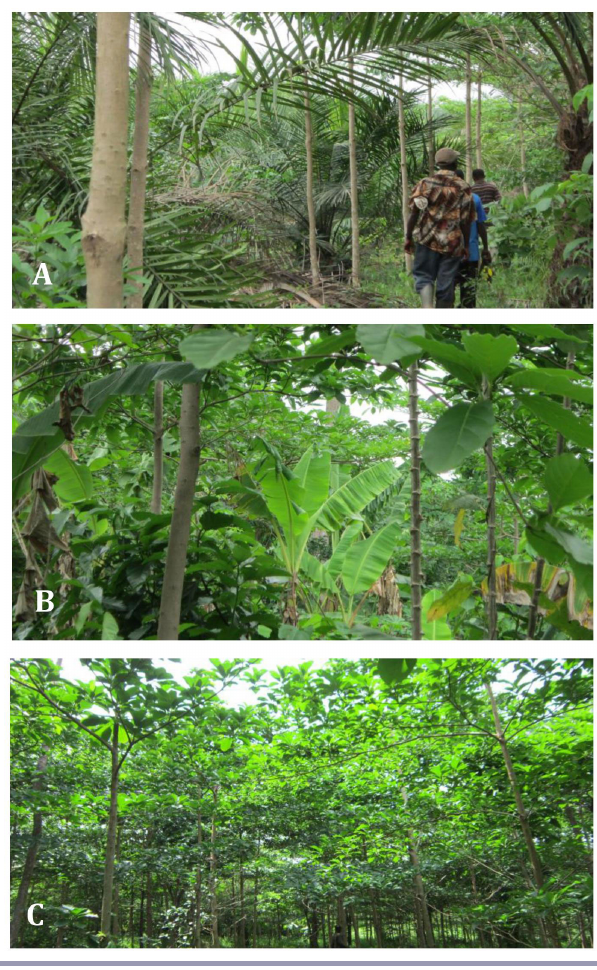
Fig. 1 . (A) Agroforestry model 1 with trees ( Terminalia superba ) along the periphery. (B) Agroforestry model 2 with trees ( T. superba ) mixed with cocoa and other subsistence crops. (C) Agroforestry model 3 with a pure stand of T. superba . Source: Photos taken by